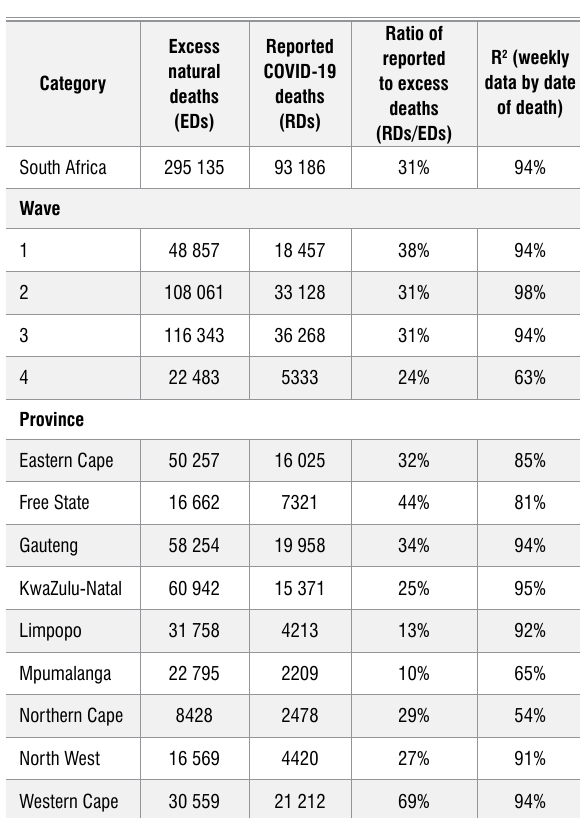
Number of excess natural deaths and reported COVID-19 deaths (cumulative to 30 January 2022) and ratio and correlation by wave and province in South